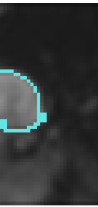
Figure 6. Final result (iteration 260), with the interpolation conditions (3 points) using Gout et al. algorithm [19].